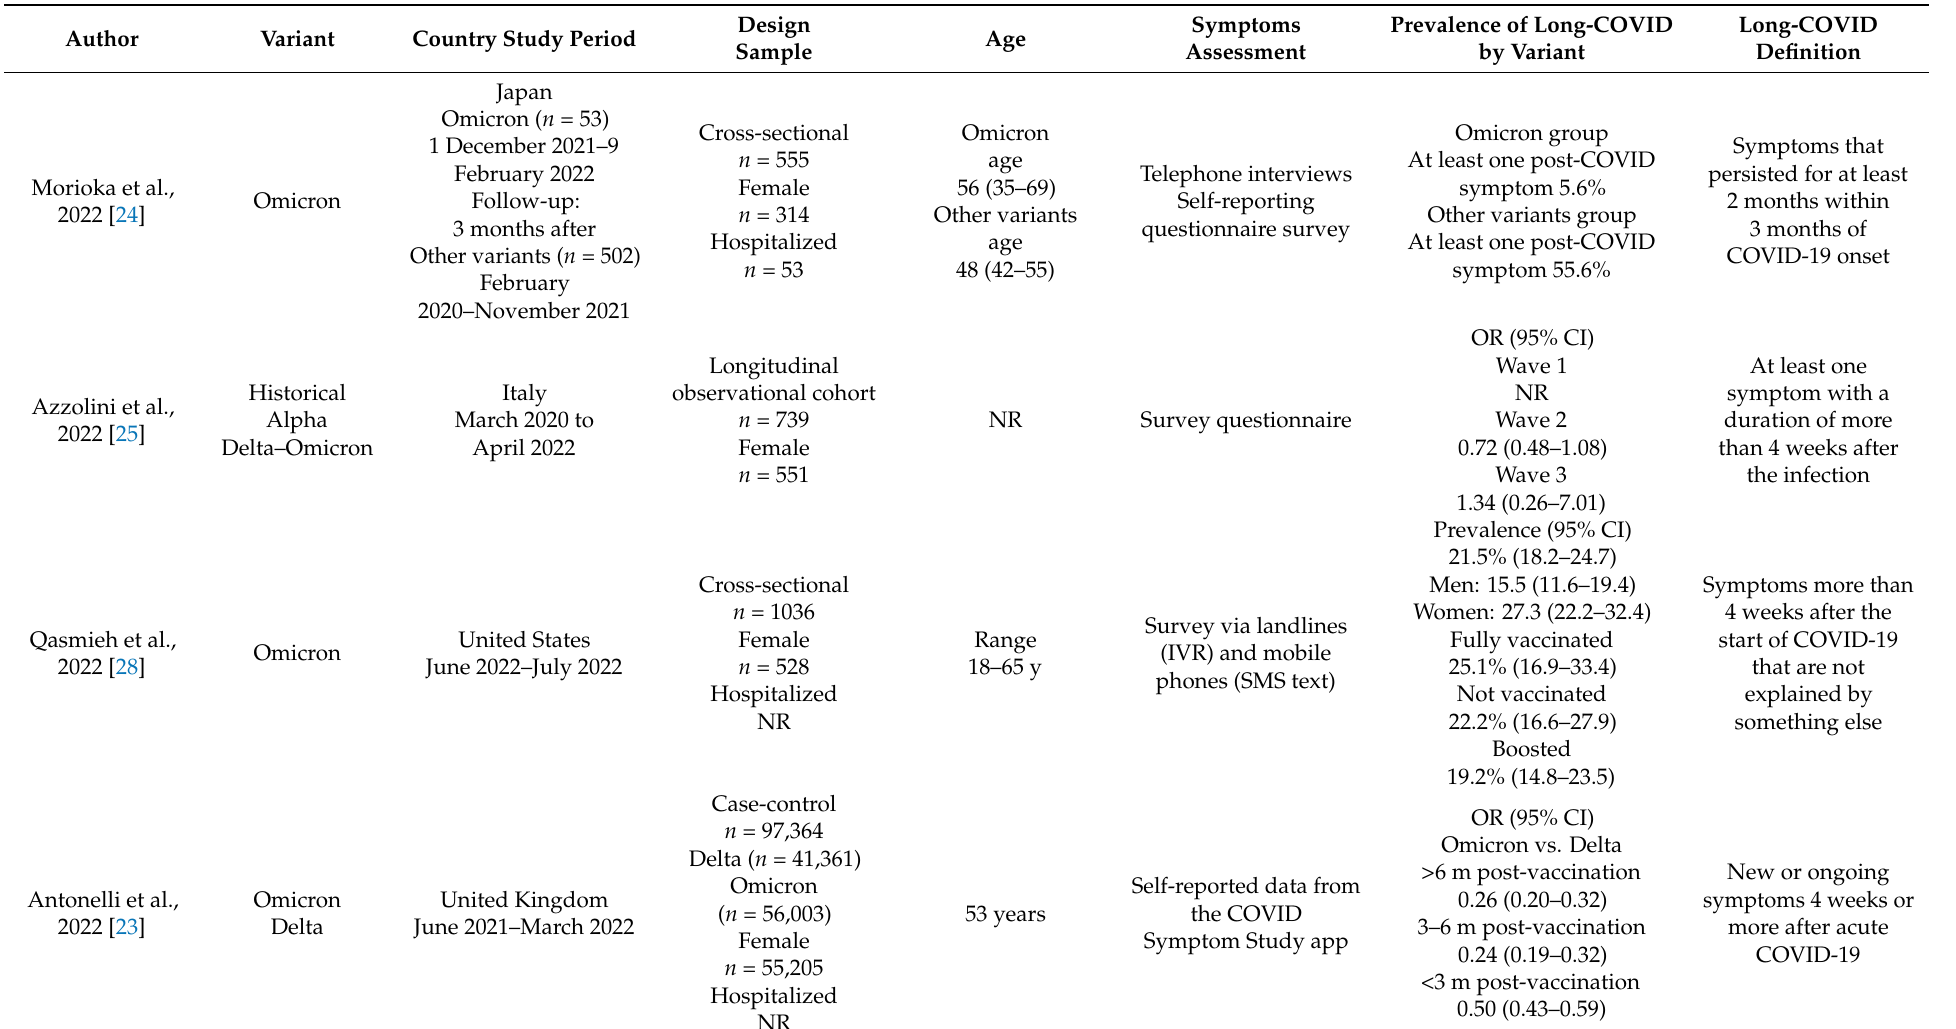
Table 2. Data from studies investigating long-COVID symptoms according to SARS-CoV-2